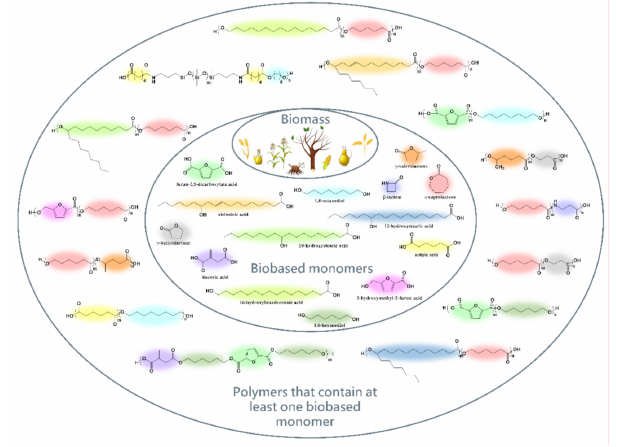
Figure 1. Examples of green polymers available through biocatalytic synthetic routes from bio-based monomers.